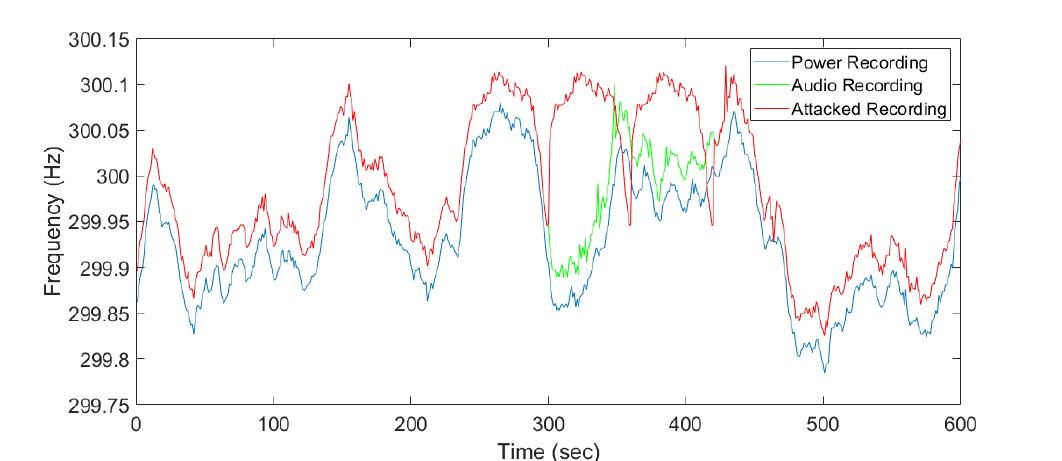
Figure 9. ENF estimated from the power and original audio